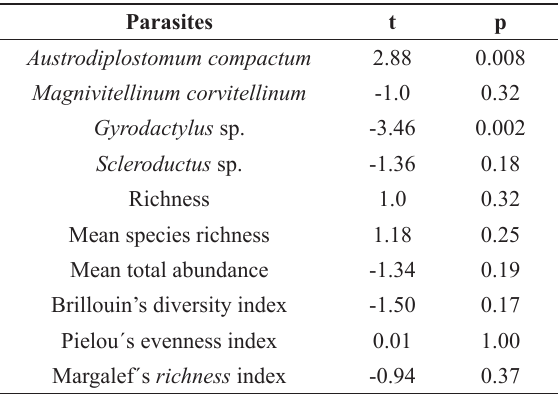
Values of the Student t-test for the comparisons of abundance of the component parasite spe cies of Hoplosternum littorale (Hancock 1828) from two locations in the Peixe River, Middle Tietê River, São Paulo State, Brazil.